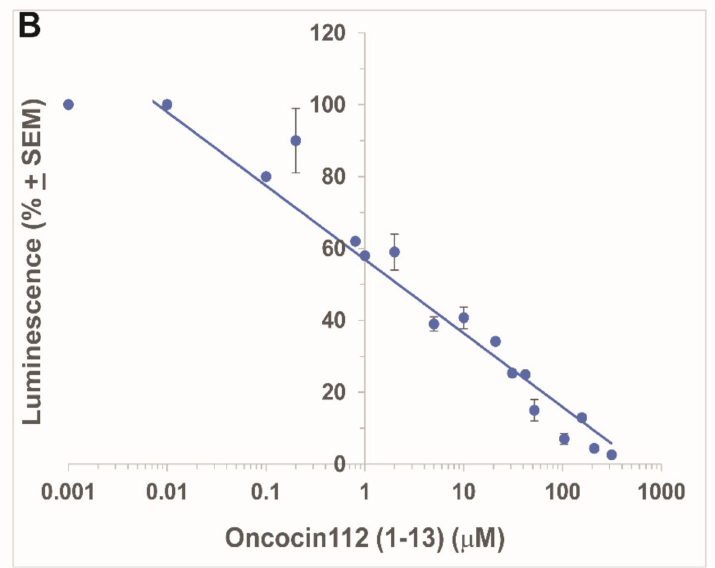
Figure 1. Inhibition of luciferase biosynthesis shown as reduction in luminescence (%) in E. coli S30 extract in the presence of increasing peptide concentrations (0.001-750 µ M). ( A ) Aea TMOF showing IC 50 of 1.0 µ M, and ( B ) oncocin112 (1–13) showing an IC 50 of 2.0 µ M. Each point is the mean of three determinations + SEM (see Section 2.3 for details). Luminescence at 100% indicates no inhibition of luciferase